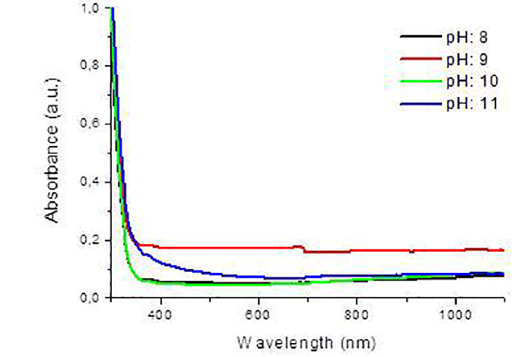
Figure 5. Absorbance of MnSe thin films obtained from baths with different